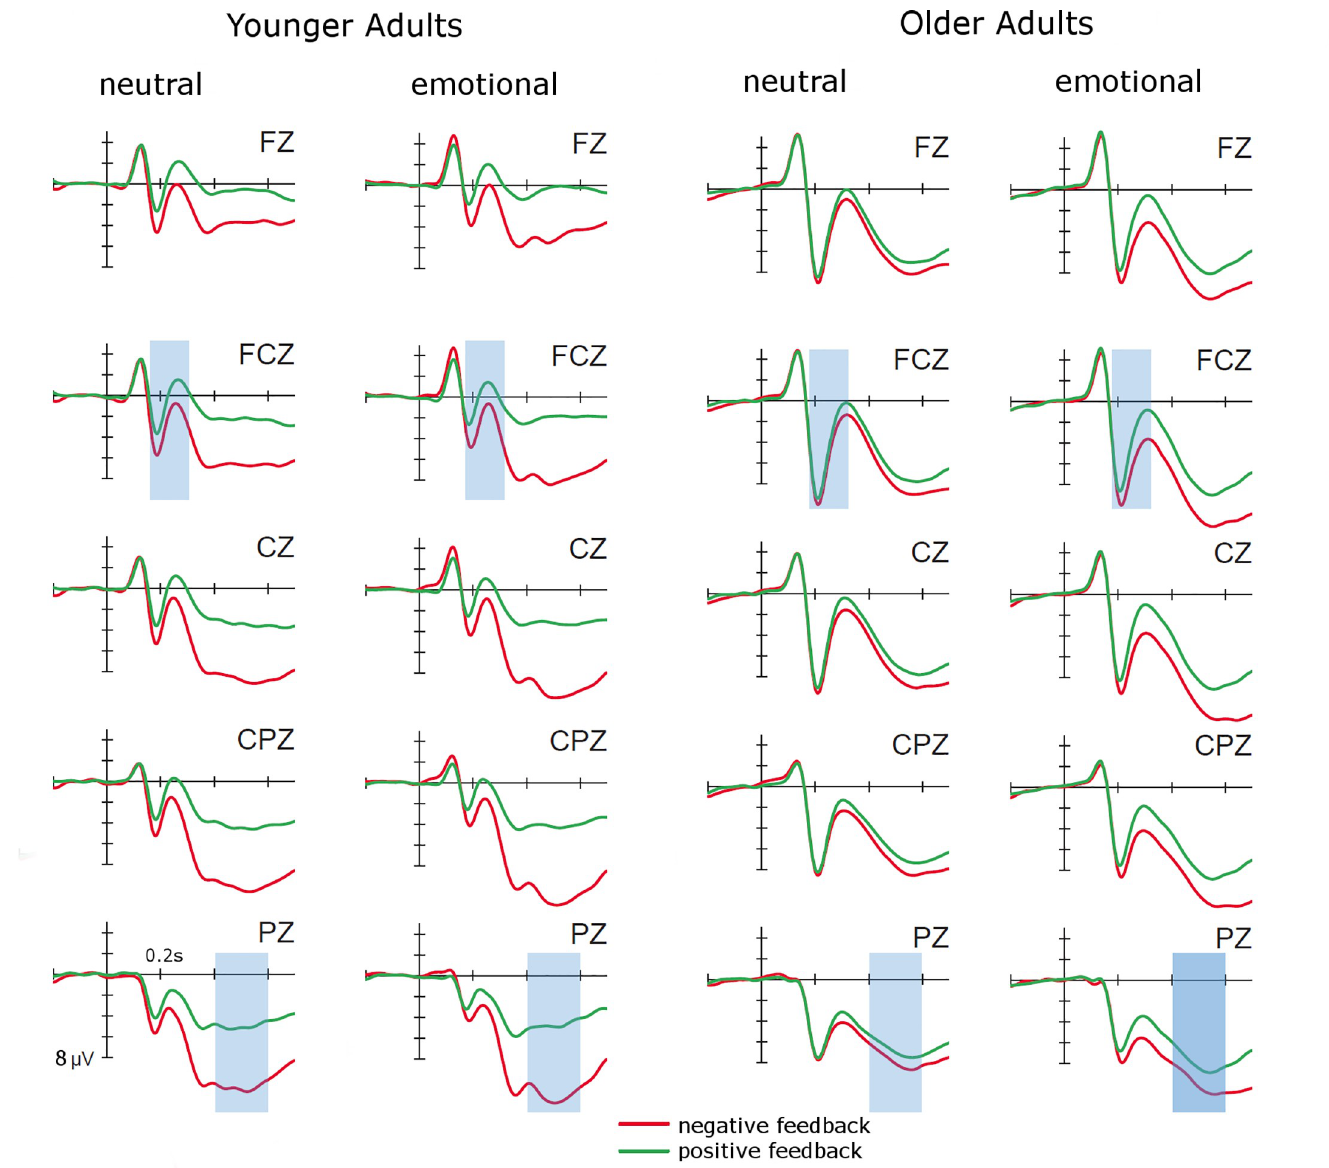
Fig 2. Feedback-locked ERPs for younger and older participants in the emotional and the neutral condition of the probabilistic learning task at electrodes Fz, FCz, Cz, CPz, and Pz.